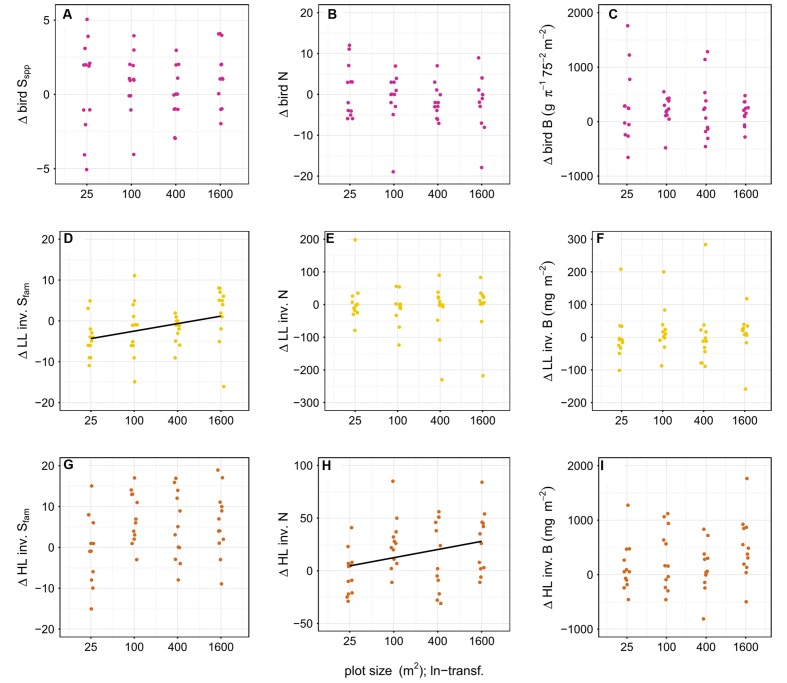
Effect of plot size on the difference in richness (Sspp = species level, Sfam = family level), abundance (N) and biomass (B) of birds (A–C), leaf-litter (LL) (D–F) and herb-layer (HL) (G–I) invertebrates (inv.) between year one and the baseline. LL invertebrate family richness and HL invertebrate abundance was significantly positively related to plot size (indicated by a black line). Plot sizes (25, 100, 400, and 1600 m2) were ln-transformed for improved representation in the figure. To avoid overplotting of data points, we used the ‘jitter’ function in R (R Core Team, 2015).